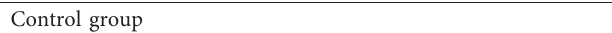
Table 2: Control group cities. Control group